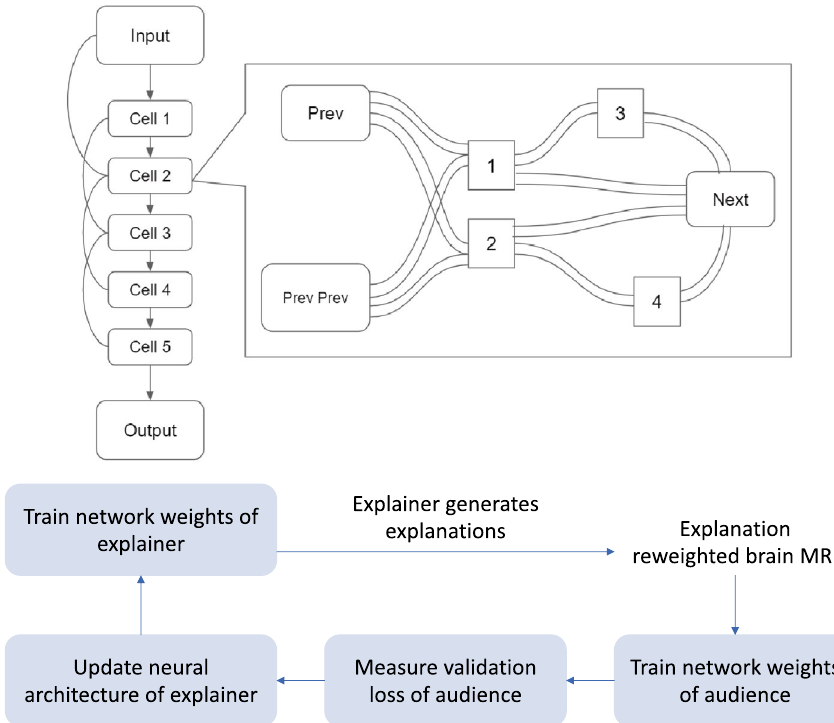
Figure 1. (Top) Search space of DARTS. (Bottom) Overview of the LeaSE framework.